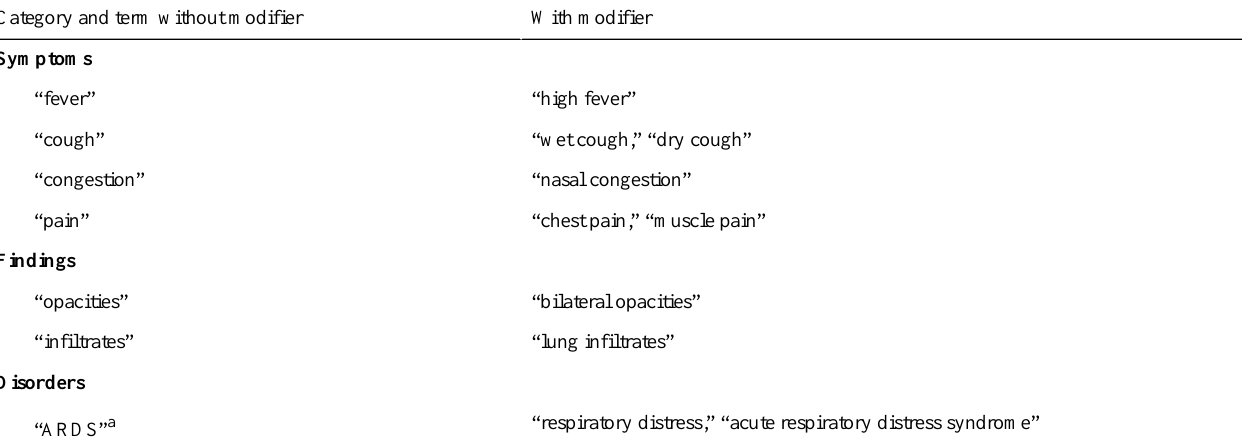
Table 2. Queried terms (symptoms, findings, and disorders) with and without modifiers. Symptoms